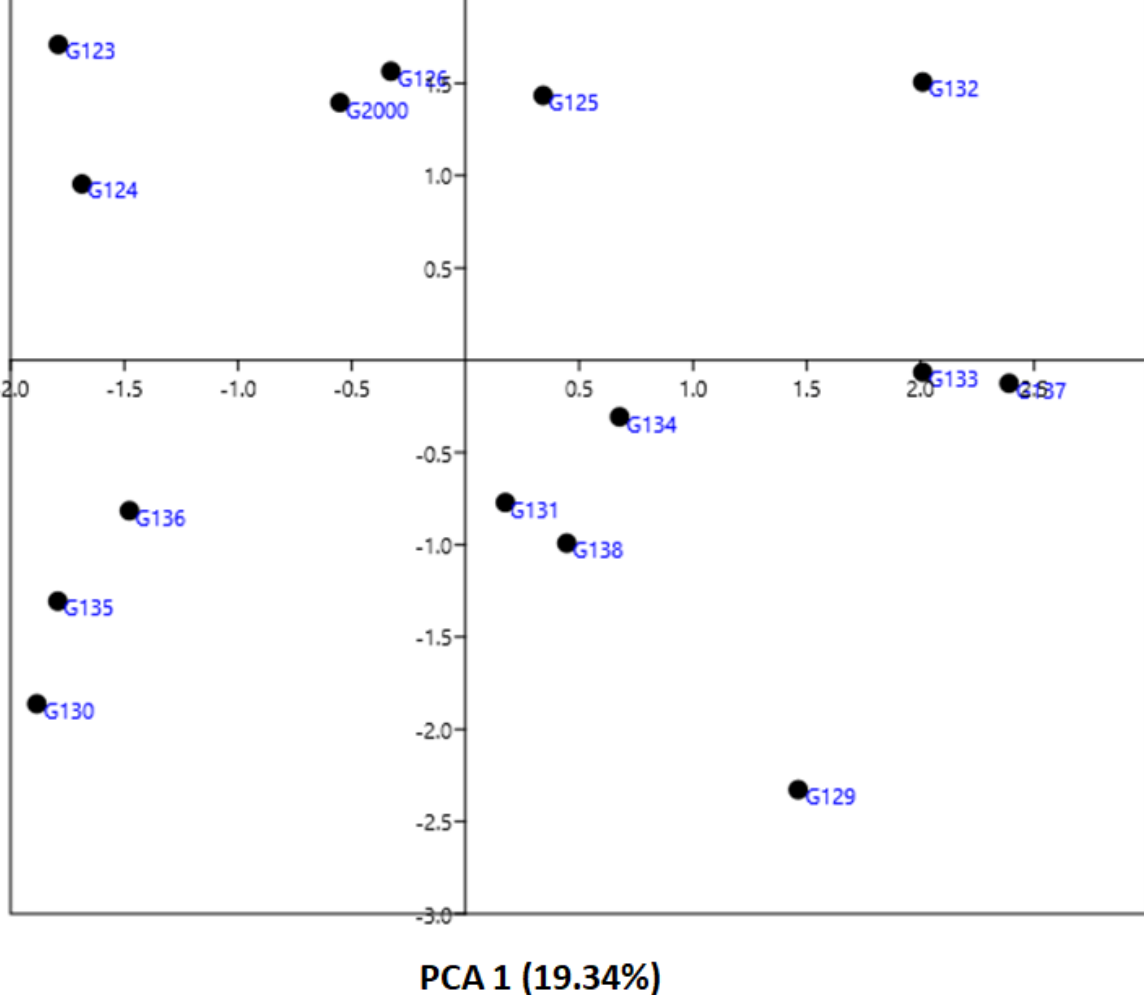
Figure 5. An illustration of the genetic diversity expressed in 15 Egyptian six-rowed barley cultivars, according to a principal component analysis (PCA) based on polymorphism of ISSR markers, using PAST software.